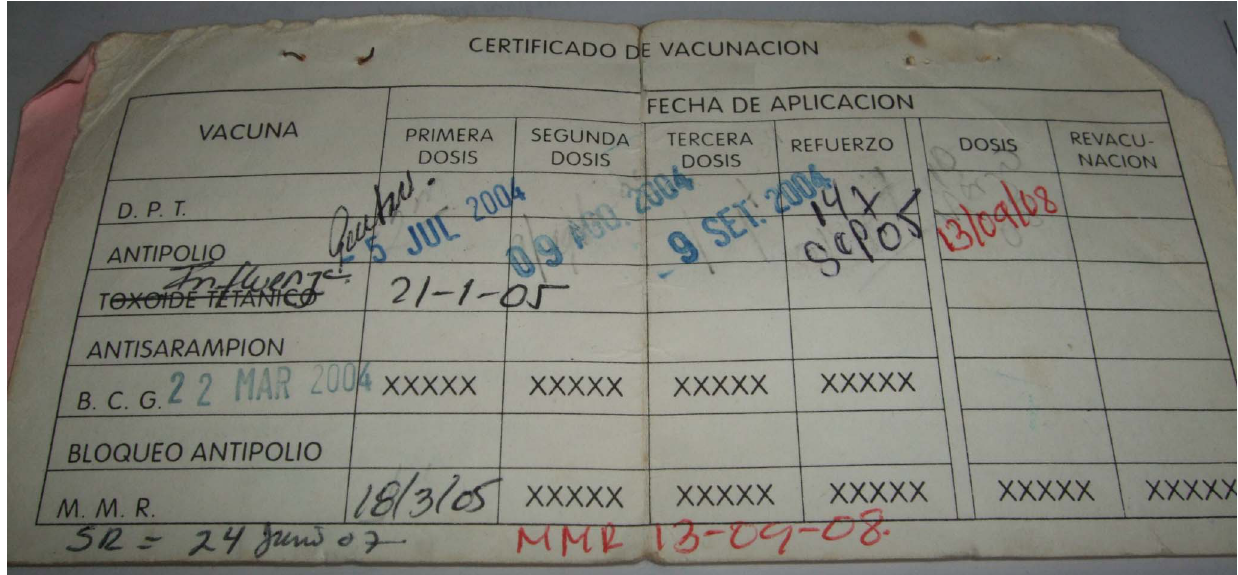
Figure 2. Several instances of improvisation on a vaccination card. (Photo courtesy of Carolina Danovaro, Pan American Health Organization.)